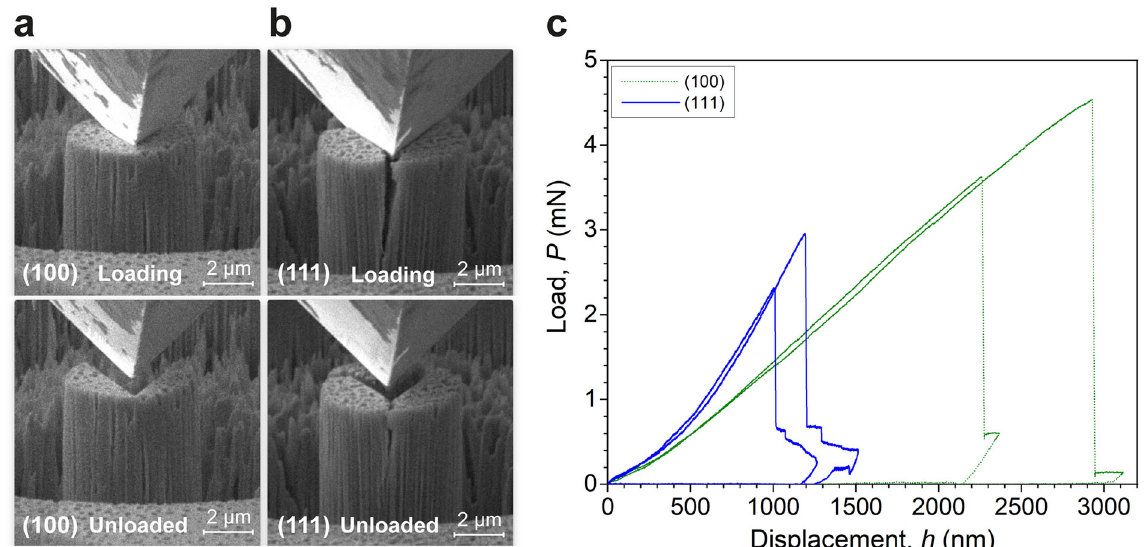
Fig. 3 In situ splitting of (100)- and (111)-oriented micropillars. In situ SEM images of the HKUST-1 micropillars in the splitting tests, when compressed on the ( a ) (100)- and ( b ) (111)-crystal facets. Recorded videos of the in situ tests are given in Supplementary Table 2. c Load vs. displacement ( P-h ) curves acquired from micropillar splitting of the two crystal